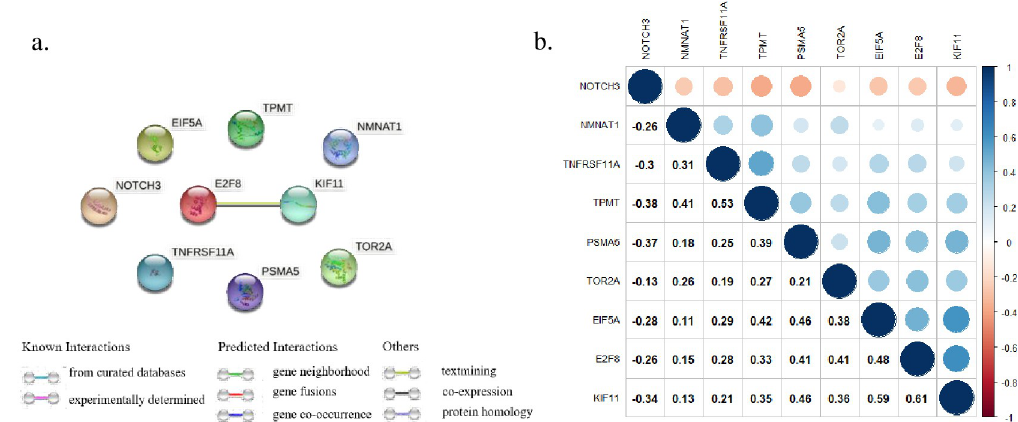
Fig 3. Interaction and correlation analysis. a) possible interactions in 9 genes based on STRING analysis. b) Spearman correlation plot of 9 genes based on expression profile.